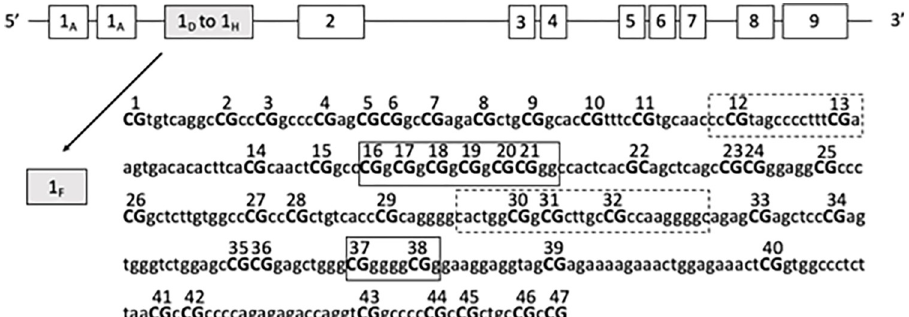
Fig 1. NR3C1 gene structure. The NR3C1 gene covers a region of more than 80 kb on chromosome V. It contains 8 coding exons (2–9) and 9 alternative spliced 5’ non coding exon 1 variants. The region encompassing exon 1 variants is also known to function as a proximal promoter. Methylation of CpG dinucleotides (capital letters, 1–47) of exon 1F promoter region is examined in this study. Boxes represent known or putative canonical NGFI-A binding sites and broken-line boxes represent non canonical NGFI-a binding sites. * CpG position followed Palma-Gudiel et al. 2015 numerotation.